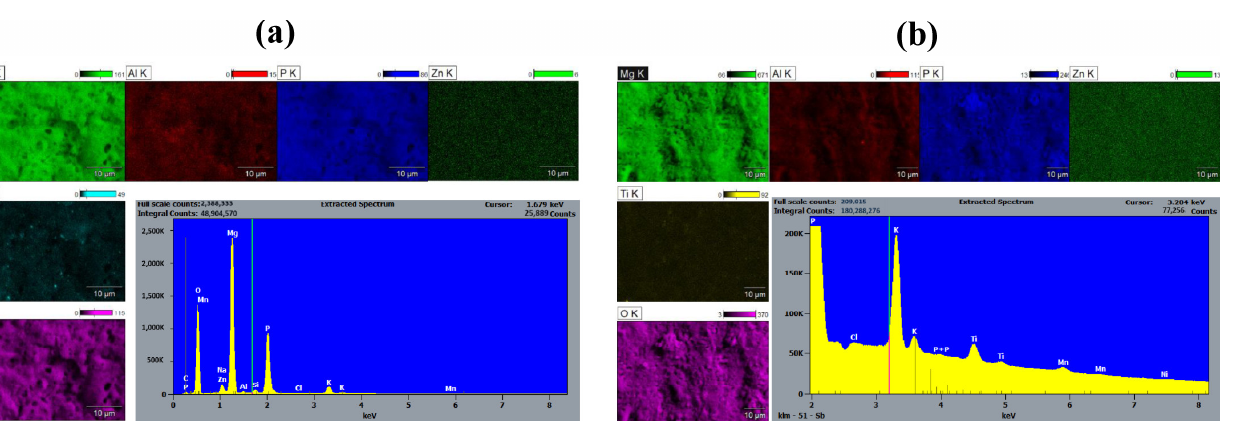
Figure 3. EDS elemental maps and spectra of the surface of ( a ) PEO@SiC-5 and ( b ) PEO@TiN-5.